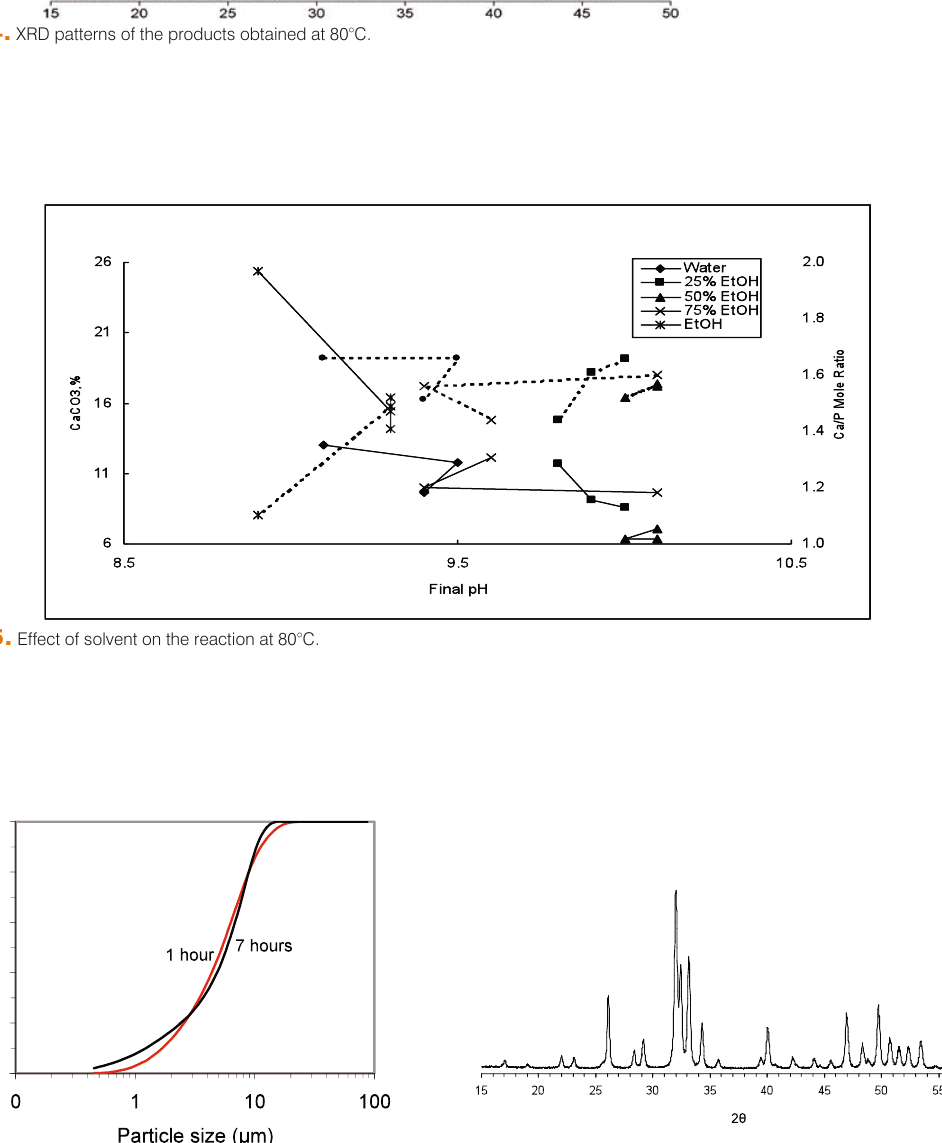
Figure 6. Effect of reaction time on the particle size of the products. Figure 7. XRD pattern of the product heated at